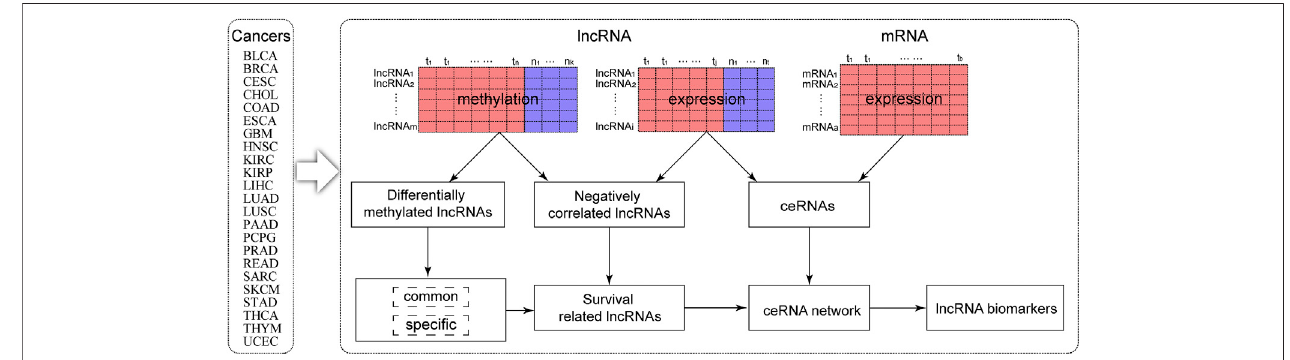
FIGURE 1 | The framework for identifying the lncRNA methylation